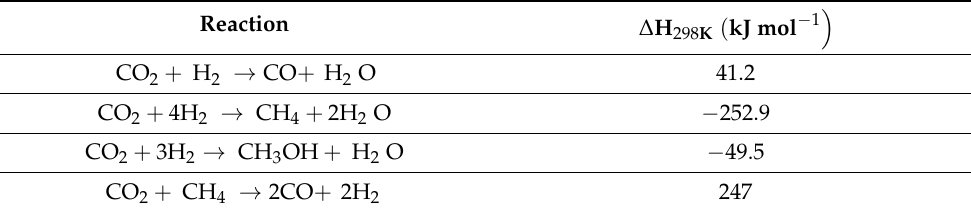
Table 3. The reaction process in which CO 2 is reduced by H 2 and CH 4 and the required